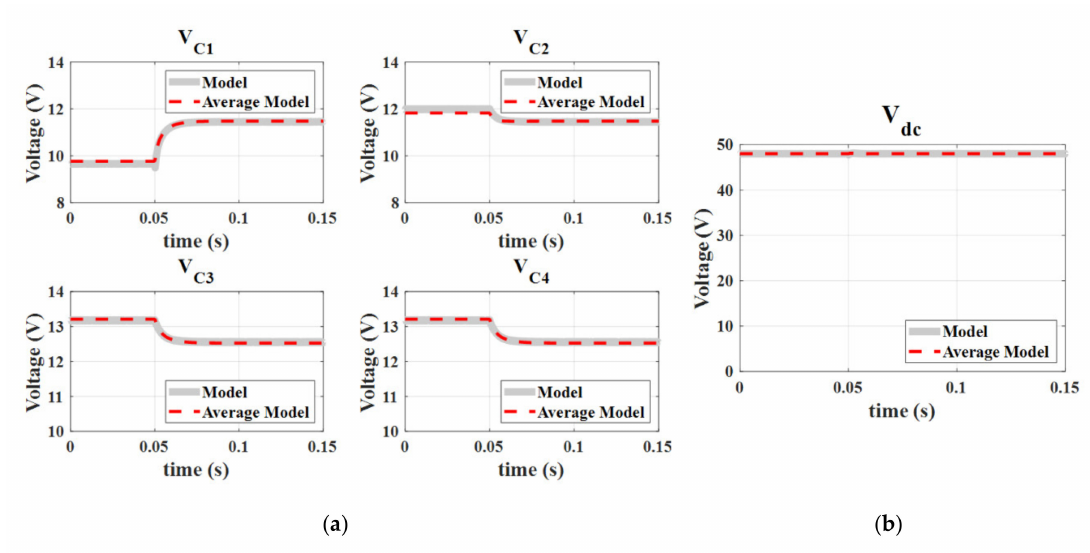
Figure 11. Simulation results in closed-loop when P 1 is changed from 63 to 100 W, P 2 is set to 100 W, and the other stacks inject the nominal power: ( a ) Voltage changes of the boost converters output capacitors connected to the stacks; ( b ) DC bus voltage.